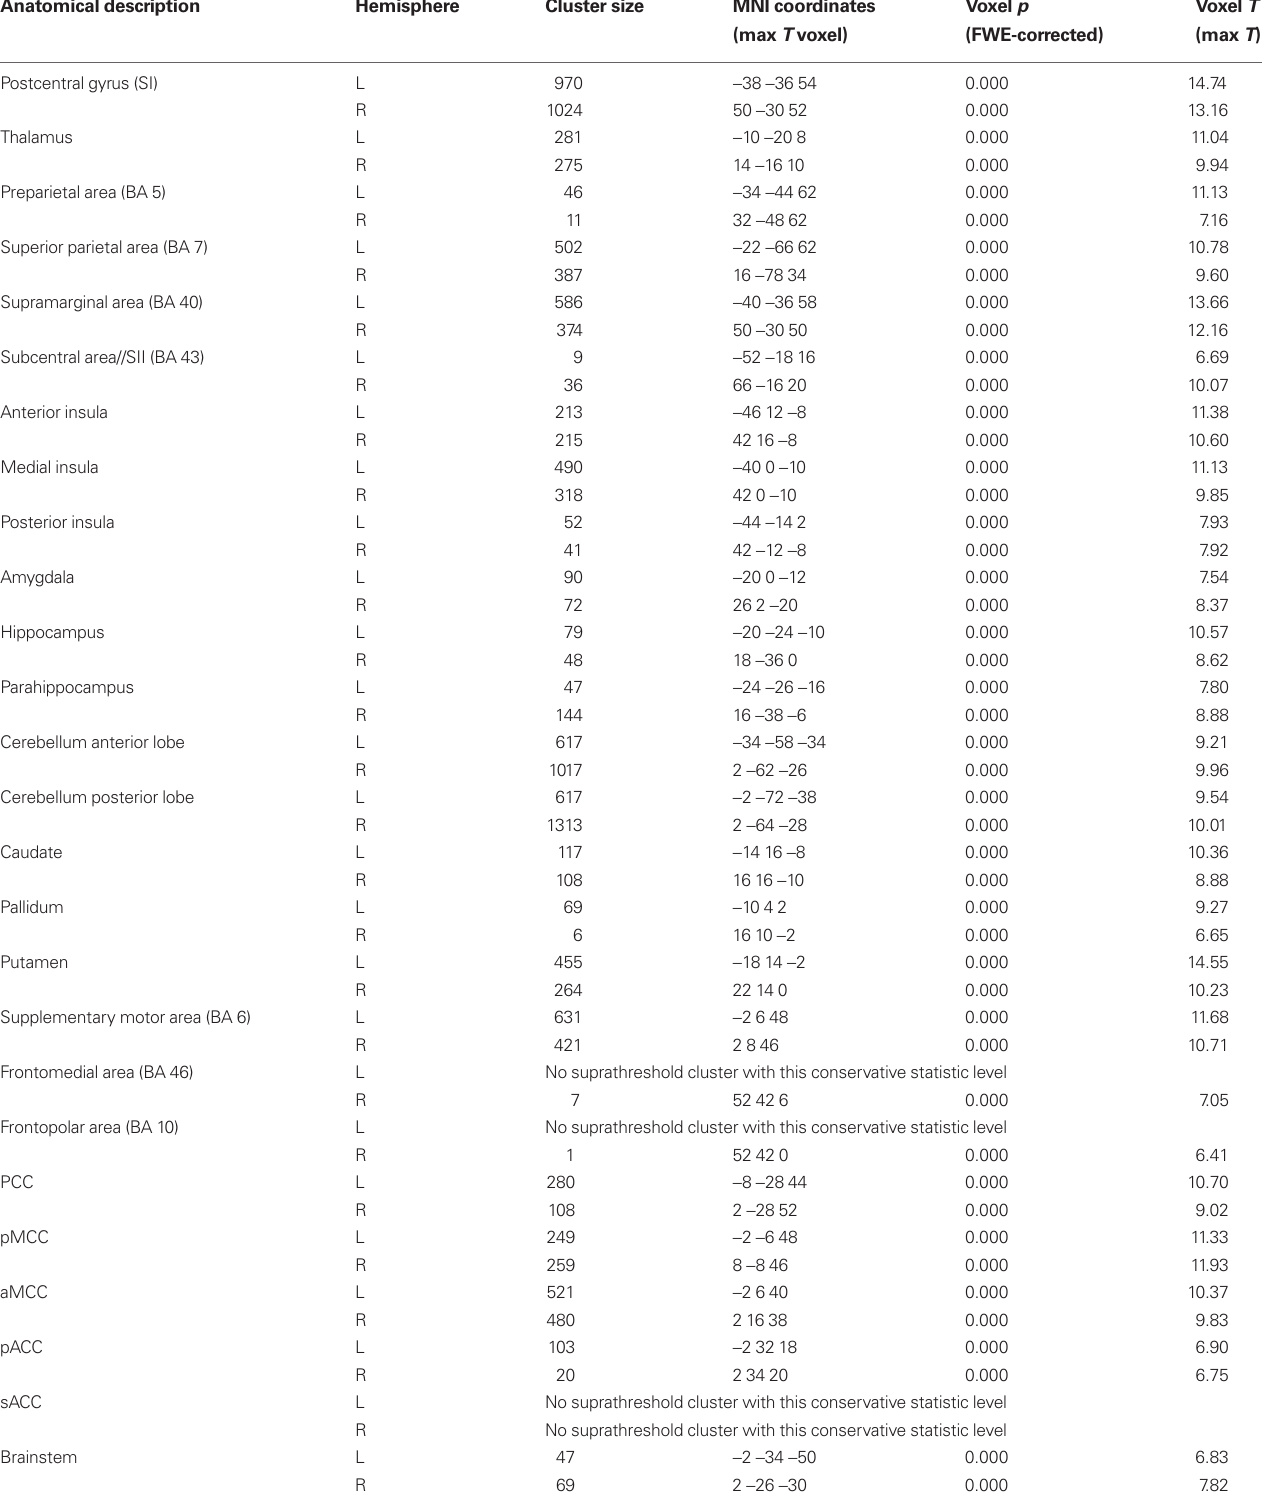
Table 2 | activation statistics in the selected regions of interest (see Materials and Methods) based on group analysis pooled across all four teeth. anatomical